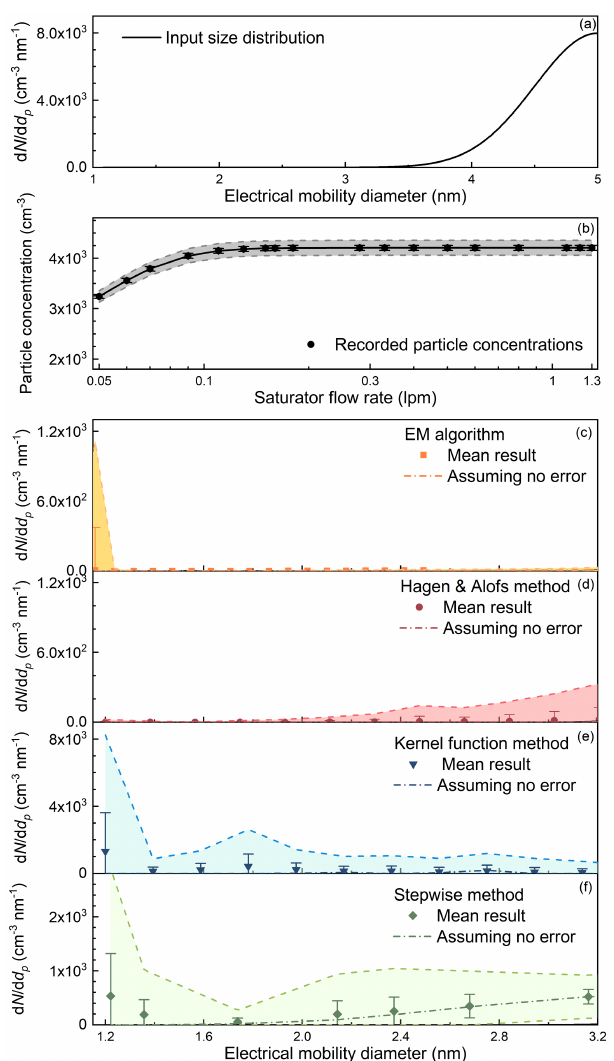
Figure 5. The recovered sub-3nm particle size distributions sim- ulated using the Monte Carlo method when the detected particles were larger than 3nm. (a) The assumed true particle size distri- bution. (b) The simulated particle concentrations recorded by the PSM. The concentrations were assumed to fluctuate due to random errors. The particle size distributions were recovered using (c) the EM algorithm, (d) the H&A method, (e) the kernel function method, and (f) the stepwise method. The error bar represents the standard deviation of the recorded particle concentration or the recovered size distribution, and the shaded area indicates the range determined by 3 times the standard deviation. The dashed lines represent the in- verted results assuming there were no random errors in the recorded particle number concentrations. Note that the scale of the vertical axis in panels (c) – (f) is different and the appearing possibility of recorded counts or the recovered size distribution is not uniform in the shaded area.